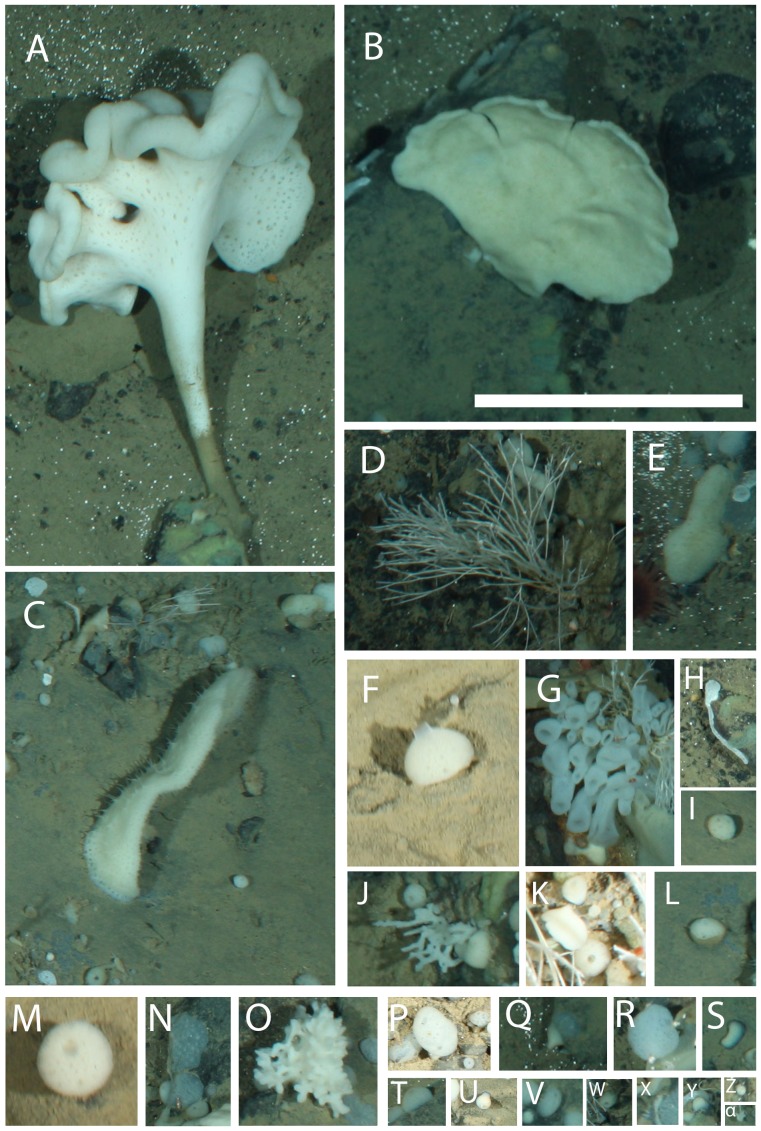
Sponges observed at the deep reef.A, Caulophacus arcticus; B, narrow white sponge; C, hairy white sponge; D, Cladorhiza gelida; E, puffy white encrustment; F, Polymastia; G, cup sponge; H, thin white encrustment; I, hole punch sponge; J, dough-like sponge; K, lobe-like sponge; L, half-and-half sponge; M, tennis ball sponge; N, Myxillina sponge; O, bulb-tipped clump; P, pipe sponge; Q, papilla sponge; R, bubble sponge; S, pancake sponge; T, white dome sponge; U, Tentorium semisuberites; V, gray dome sponge; W, volcano sponge; X, slipper sponge; Y, rocket sponge; Z, circle sponge; α, flame sponge. Scale bar  = 20 cm.